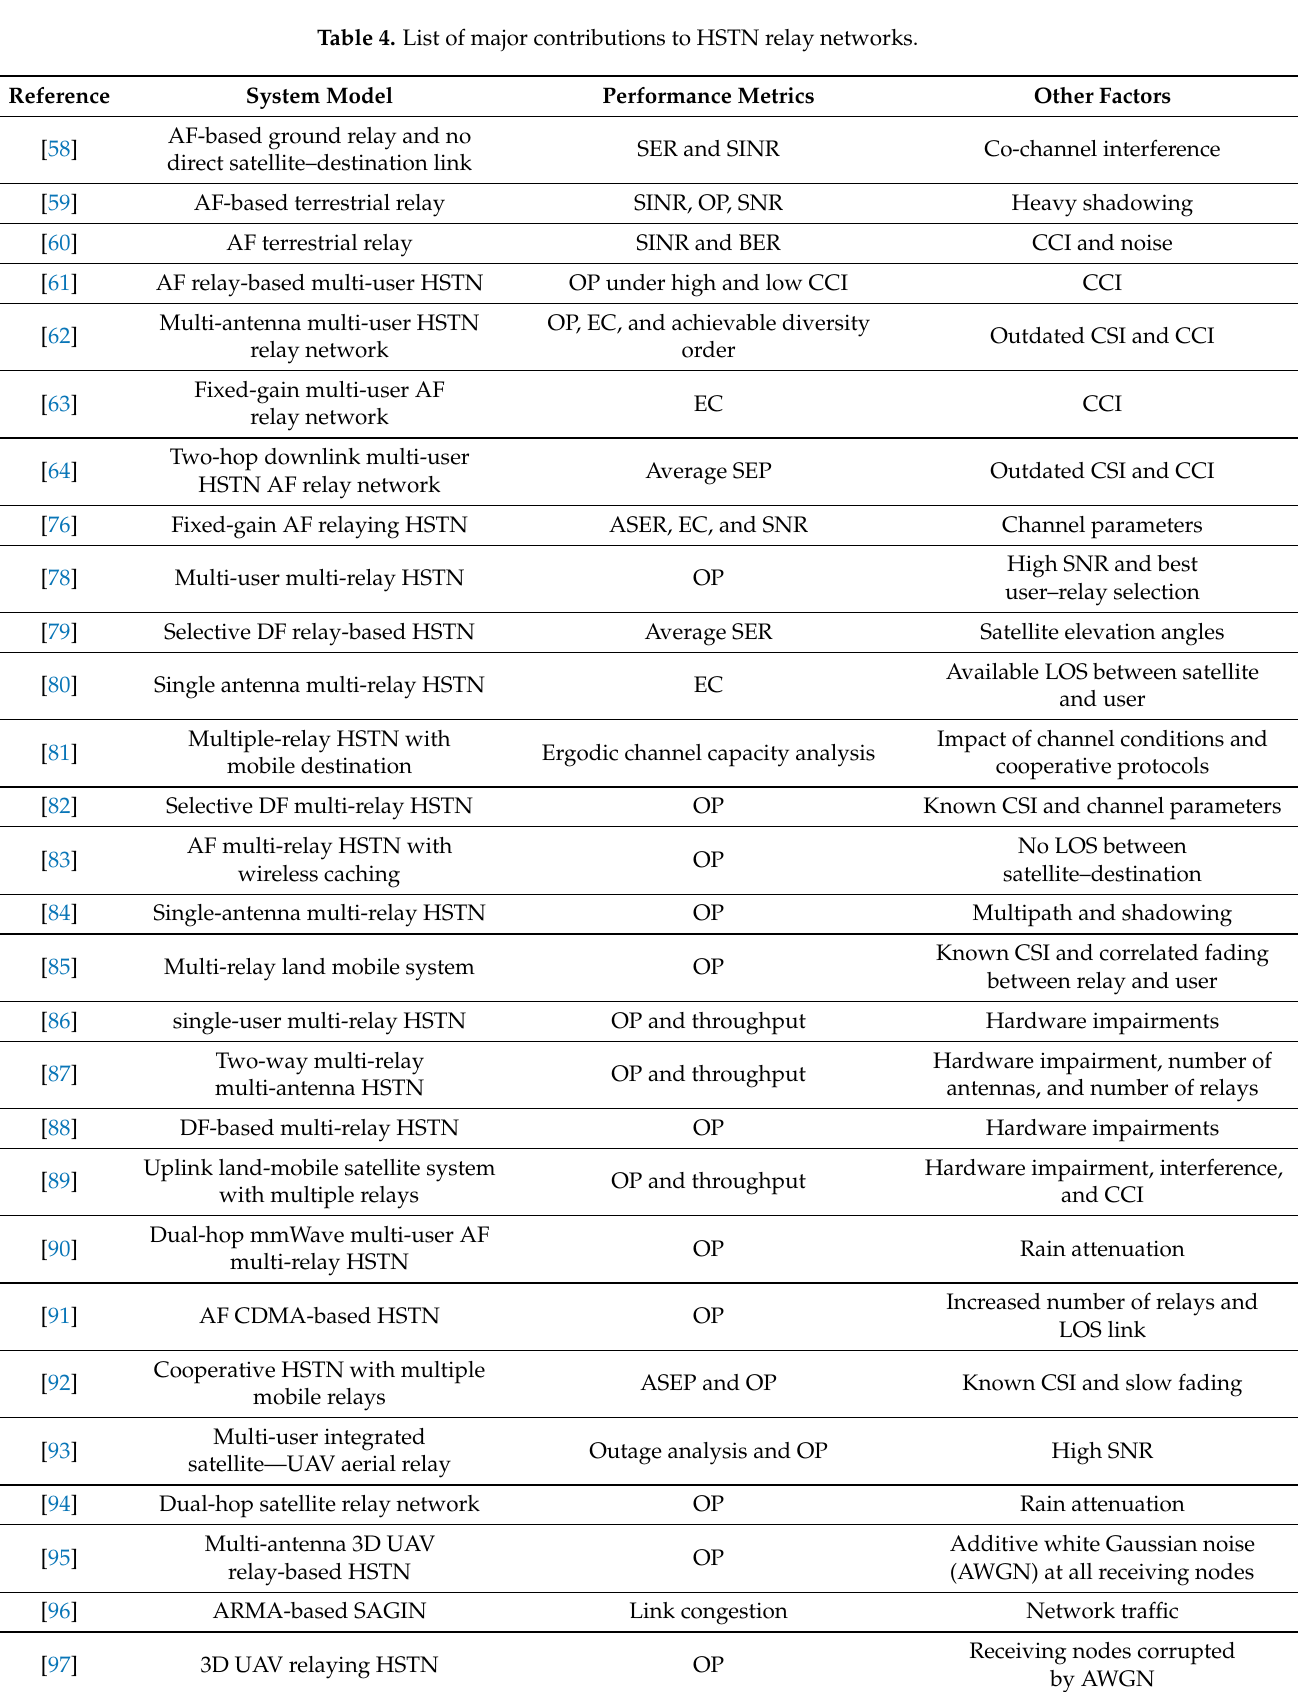
Table 4. List of major contributions to HSTN relay